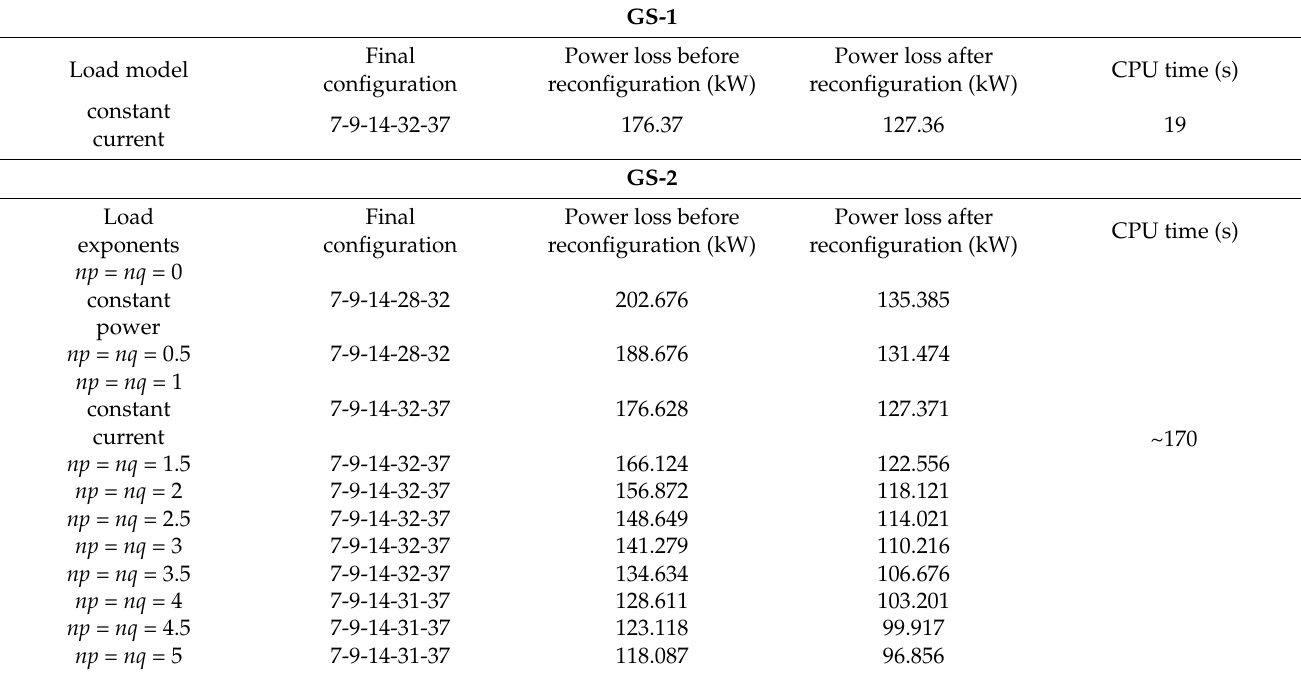
Table 2. The 33-bus system reconfiguration results.